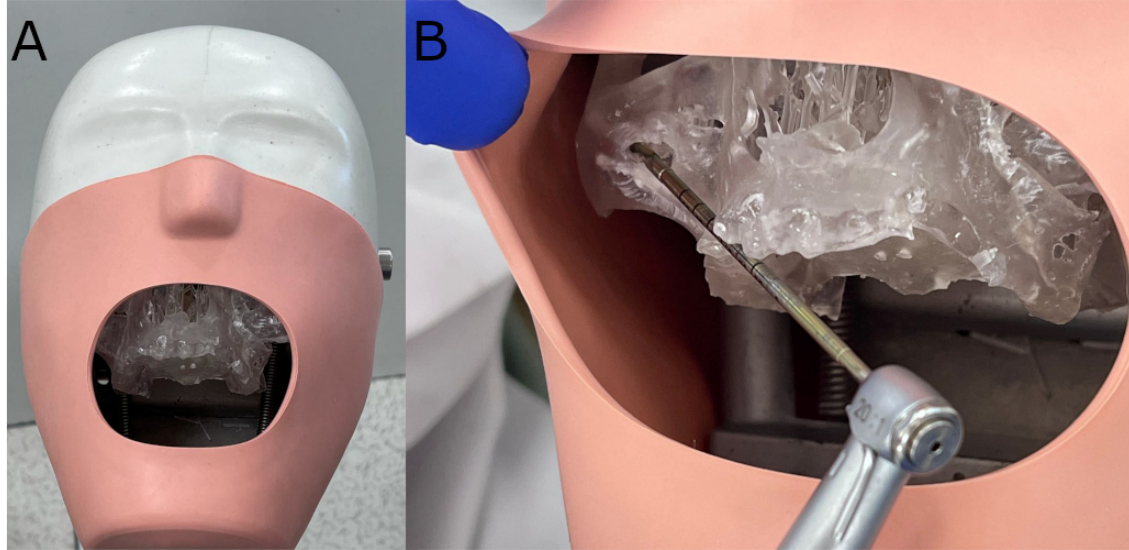
Figure 2. ( A ) Polyurethane model fixed onto an artificial head and ( B ) drilling procedure.